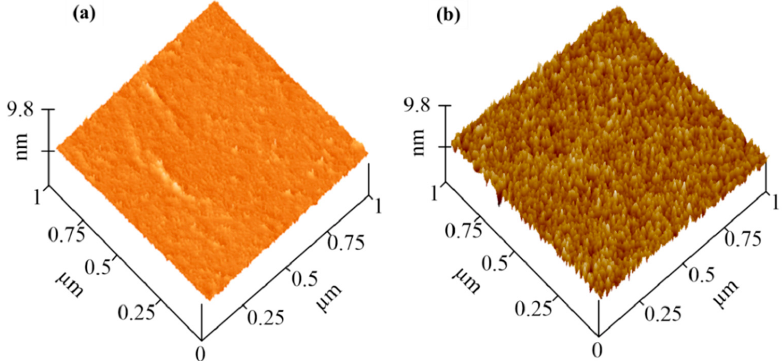
Figure 2. Atomic force microscopy (AFM) morphologies of ( a ) a PDA-modified surface and ( b ) a 12 h CS grafted surface.